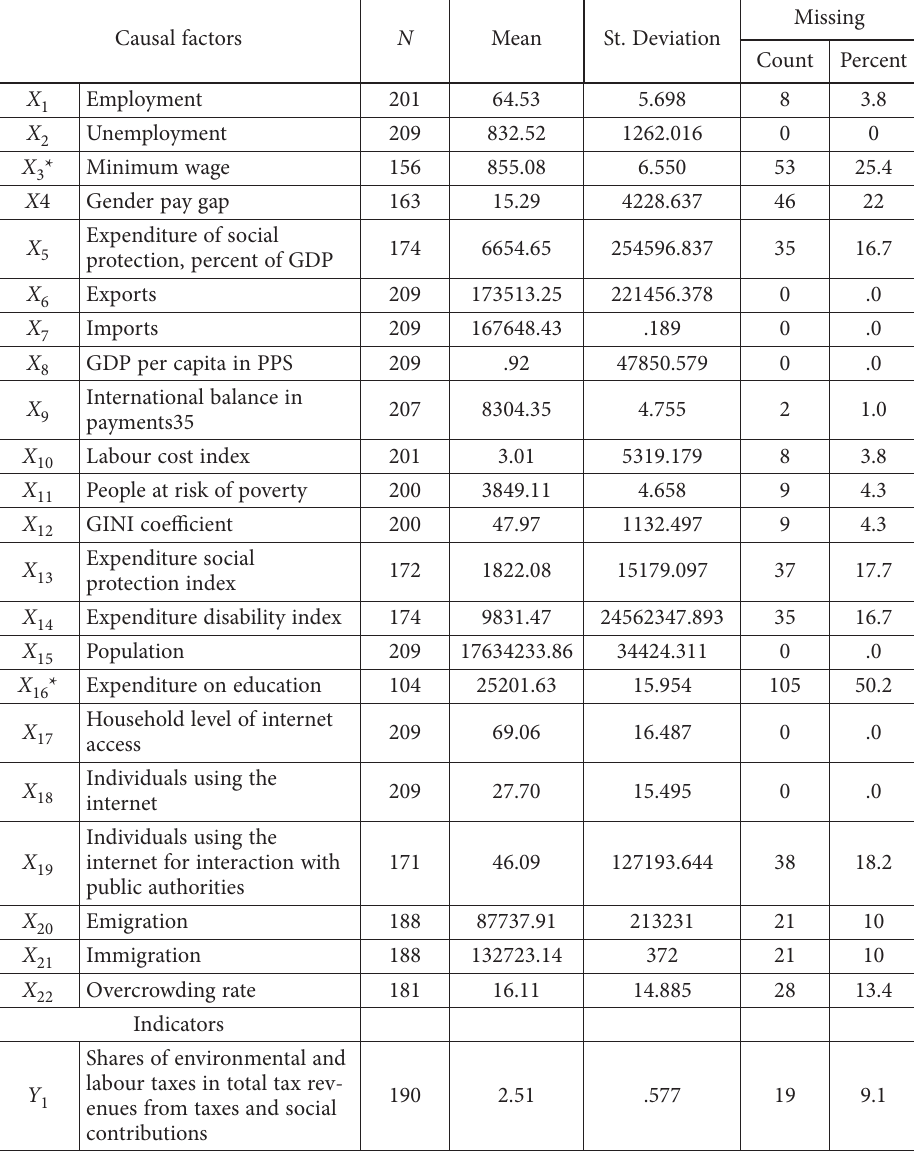
Table 2. Statistics of the shadow economy’s causal factors and